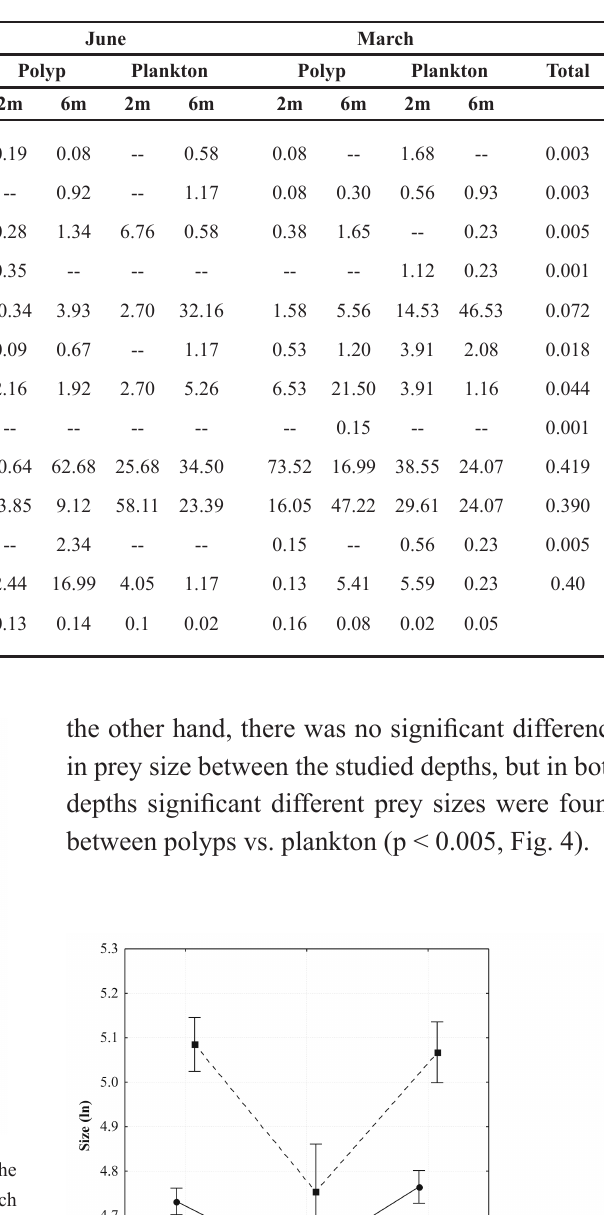
Relative abundance (%) of prey items in the plankton and in the gastric cavities of the polyps of Carijoa riisei during the sampling period in Porto de Galinhas beach